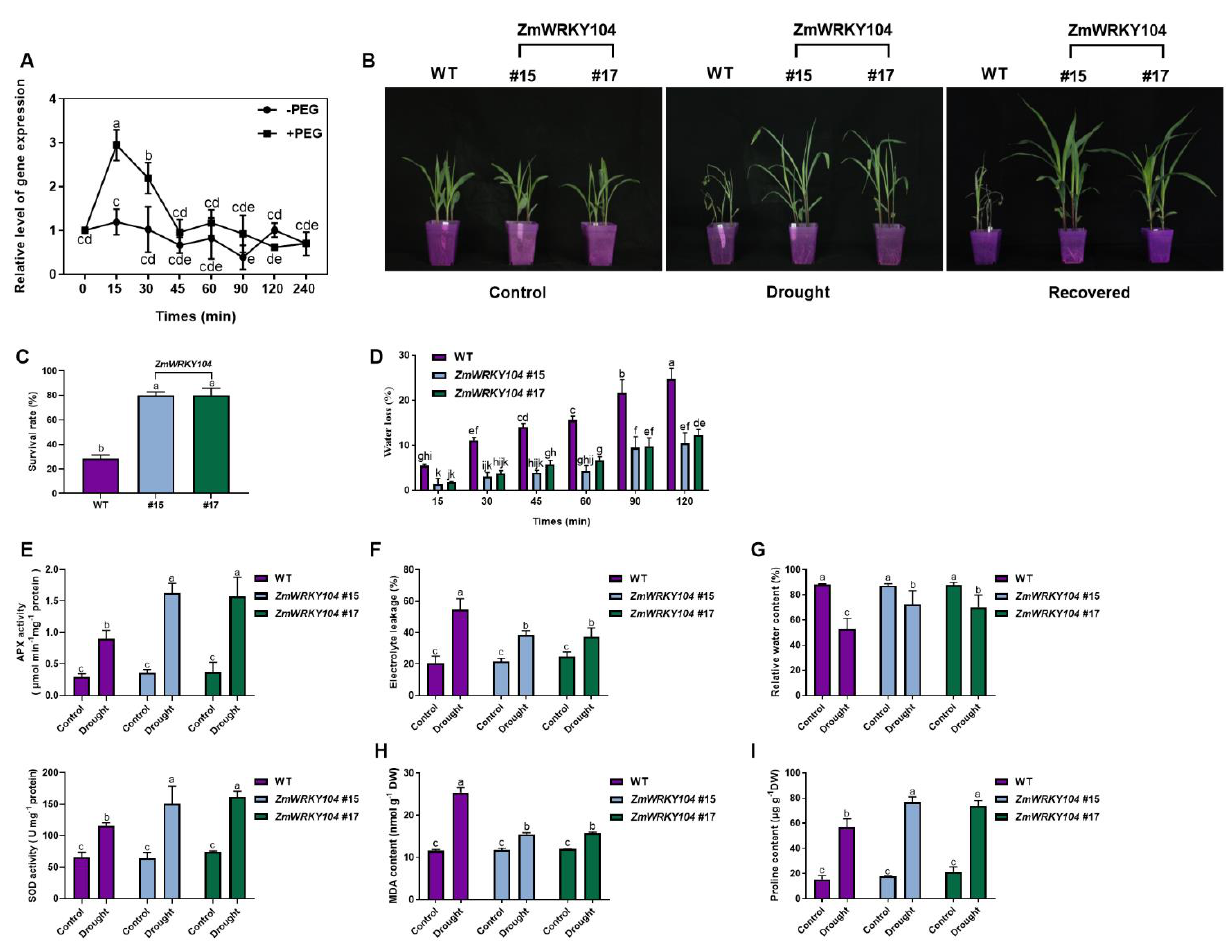
Figure 7. The overexpression of ZmWRKY104 confers drought tolerance in transgenic maize plants. ( A ) PEG induces the upregulation of ZmWRKY104 expression in the leaves of maize plants. Expression analysis of ZmWRKY104 in leaves of maize plants exposed to 10% ( w / v ) polyethylene glycol (PEG6000) treatments for various times as indicated. The expression level relative to ZmActin was analyzed by qRT-PCR. ( B ) Phenotype of ZmWRKY104 in transgenic maize. Seedlings were subjected to native drought conditions after the three-leaf stage (water was withheld) for 10 days and then rewatered using normal protocols for 3 days. During the experiment, control plants were watered every day. The drought test was repeated 3 times, at least 35 plants were used for each individual line, and a representative picture was displayed. Scale bars = 7 cm. ( C ) Survival rate of maize plants after rewatering for 3 days. ( D ) Analysis of water retention in ZmWRKY104 -OE transgenic lines. Maize leaves isolated from transgenic and WT seedlings were positioned for 2 h at 25 ◦ C, and the percentage of water loss at different time points was recorded. ( E ) Analysis of the activities of APX and SOD of ZmWRKY104 -OE transgenic lines under drought stress. The activities were testing of the seedling’s leaves treated with Control (distilled water) or drought. ( F ) Electrolyte leakage; ( G ) the relative water content, ( H ) The MDA contents and ( I ) The proline contents were determined under drought stress and in normal-watered control plants in the leaves of ZmWRKY104 -OE transgenic plants and WT plants. Values are the means ± SE of three different experiments. According to Duncan’s multiple range test, means represented by the same letter did not significantly differ at p < 0.05.